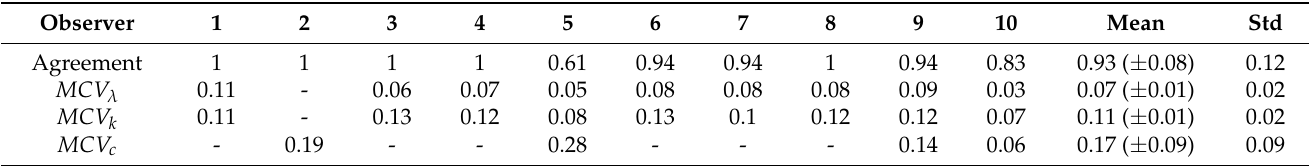
Table 3. Intra-observer variability across image